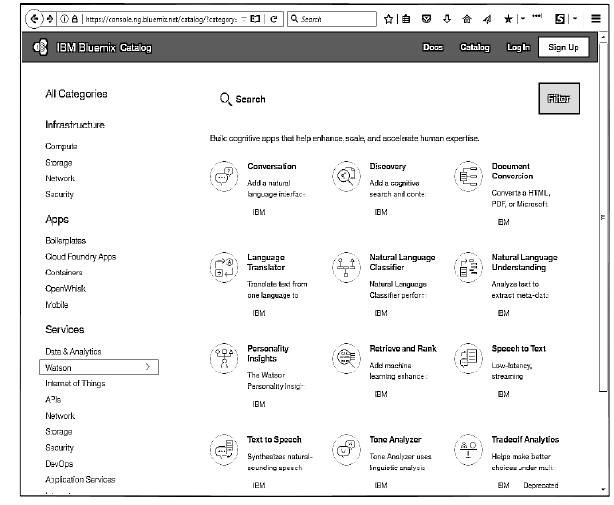
Fig. 16. Provided SDKs to use Microsoft Azure services in supported runtime environments..